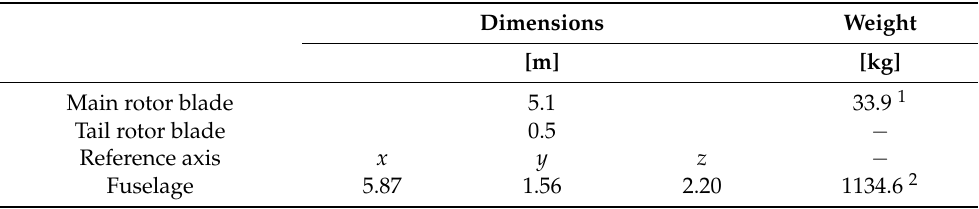
Table 2. Dimensions are taken from [23], page 7, and the weight of the main rotor blade from [19], page